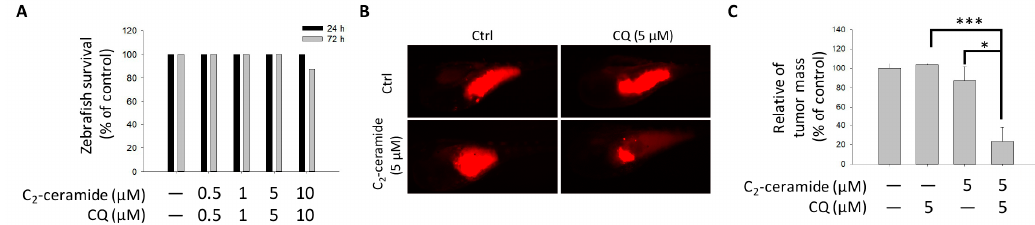
Figure 5. Effect of C 2 -ceramide and CQ on the growth of NSCLC xenografted cells. ( A ) The survival rate of zebrafish larvae following C 2 -ceramide and CQ exposure. ( B ) The tumor mass in the zebrafish xenograft model. The intensity of red fluorescence indicates the relative tumor mass of xenografted H1299 cells. Sample size n > 10 embryos for each group. ( C ) The quantitative analysis of ( B ). All data are presented as mean ± standard error (S.E.) (* p < 0.05 and *** p < 0.001).